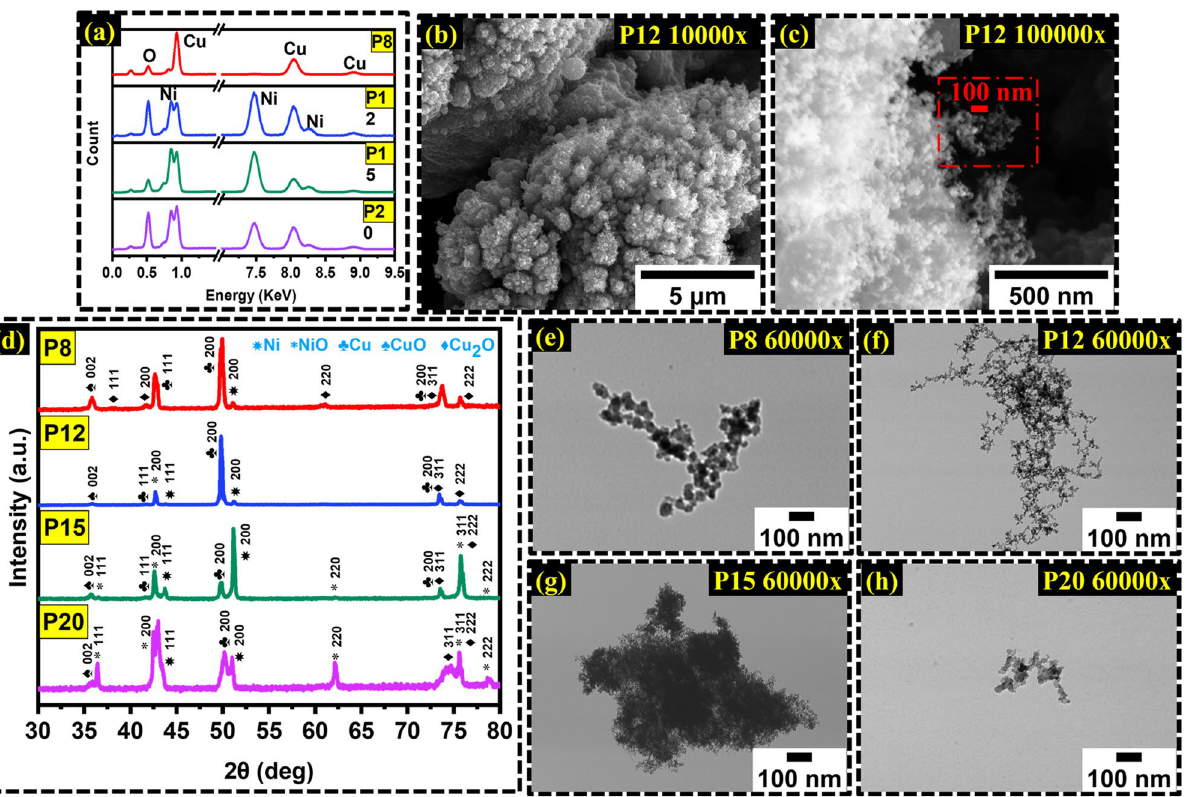
Figure 3. ( a ) The EDX data demonstrates elemental composition and the presence of oxygen caused during laser irradiation. ( b ) The SEM image of P12 with × 10,000 magnification shows fibrous growth on the